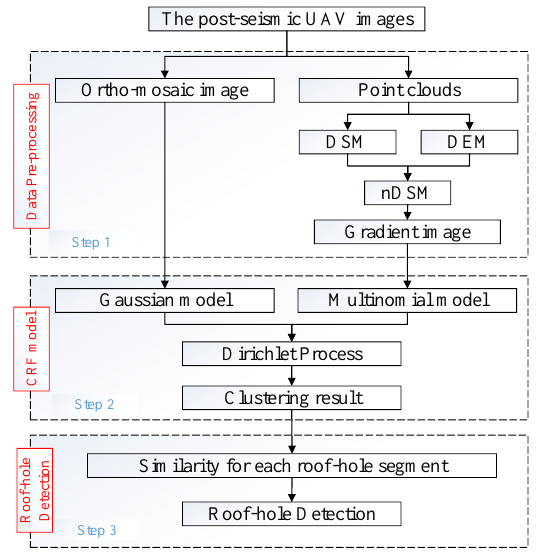
Figure 4. Flowchart of the proposed method for detecting